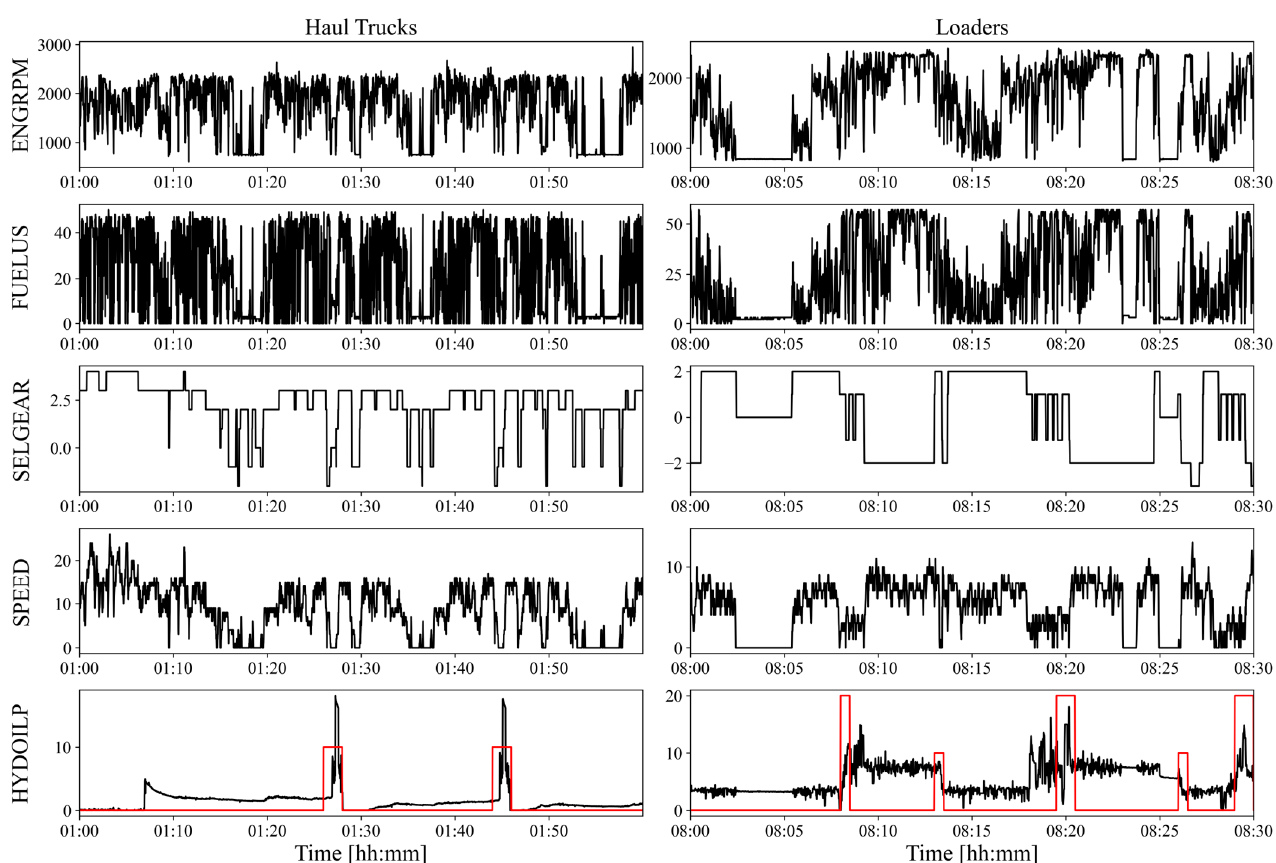
Figure 9. Examplary detection performed by model for haul trucks (left) and by model for loaders (right). Each detection is presented as a red line (scaled by 10 to be visible) presented at HYDOILP variable. All variables presented are raw.